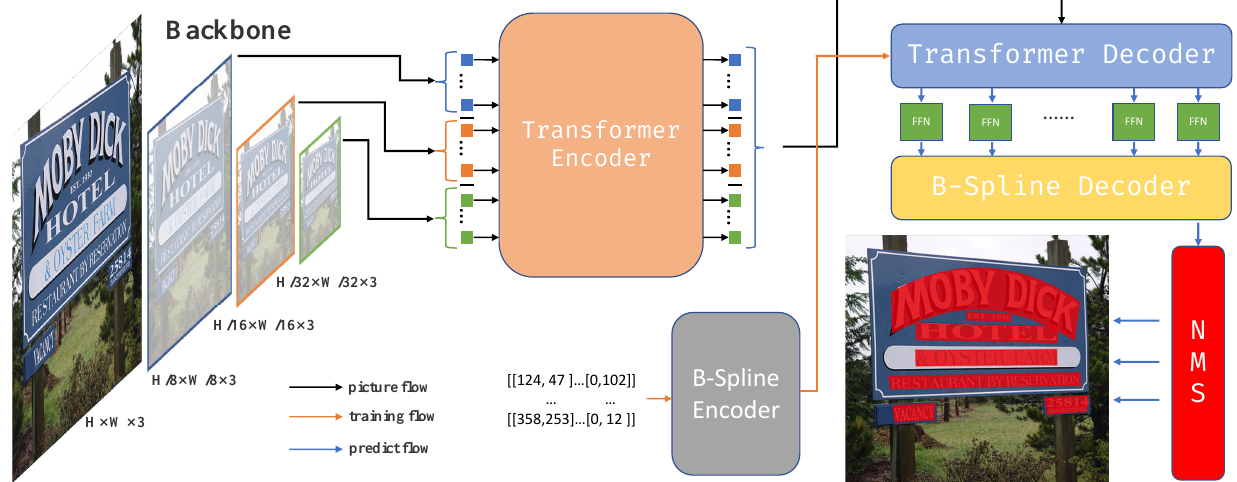
Figure 1. Architecture of the proposed